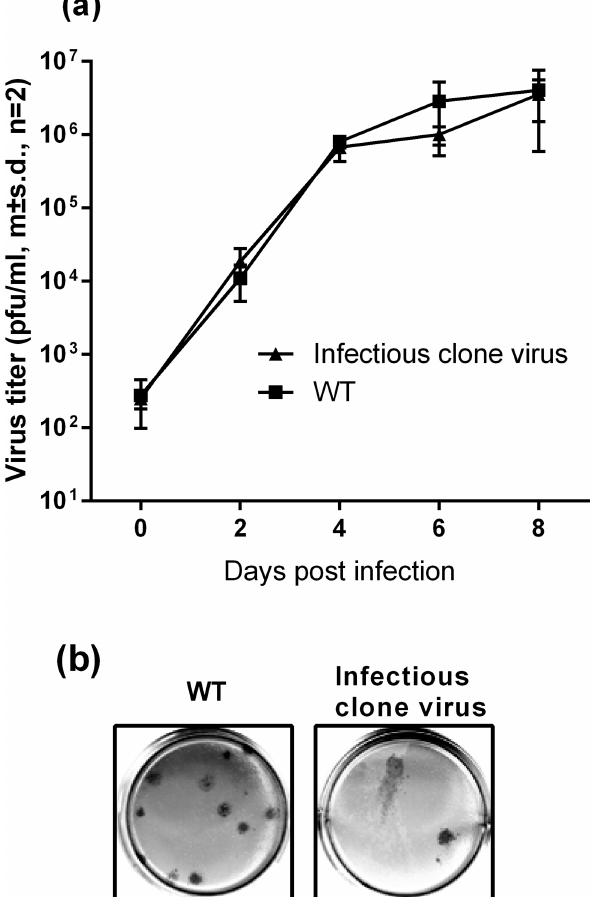
Fig 1. Growth kinetics and plaque morphology of wild type (WT) and infectious clone-derived DENV1 in C6-36 mosquito cells. (a) Yield of virus after C6-36 cells were infected at an MOI of 0.1 and (b) plaque morphology identified by indirect ELISA seven days